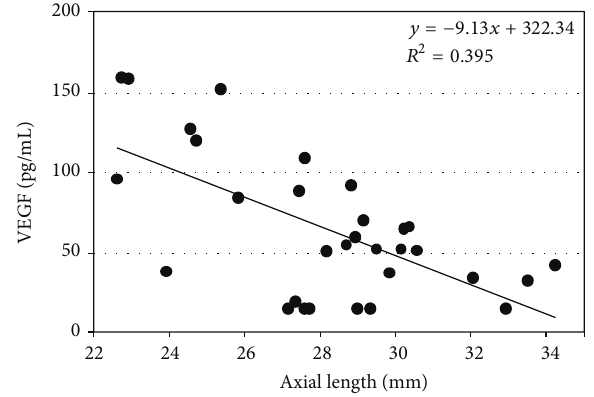
Figure 2: The graph shows the association between the vascular endothelial growth factor (VEGF) concentration in the aqueous humorandtheaxiallengthineyeswithhighmyopiawithoutmyopic choroidal neovascularization (CNV) and controls. The VEGF con- centration is correlated negatively with the axial length ( 𝑅 = 0.629 , 𝑃 < 0.001 ).